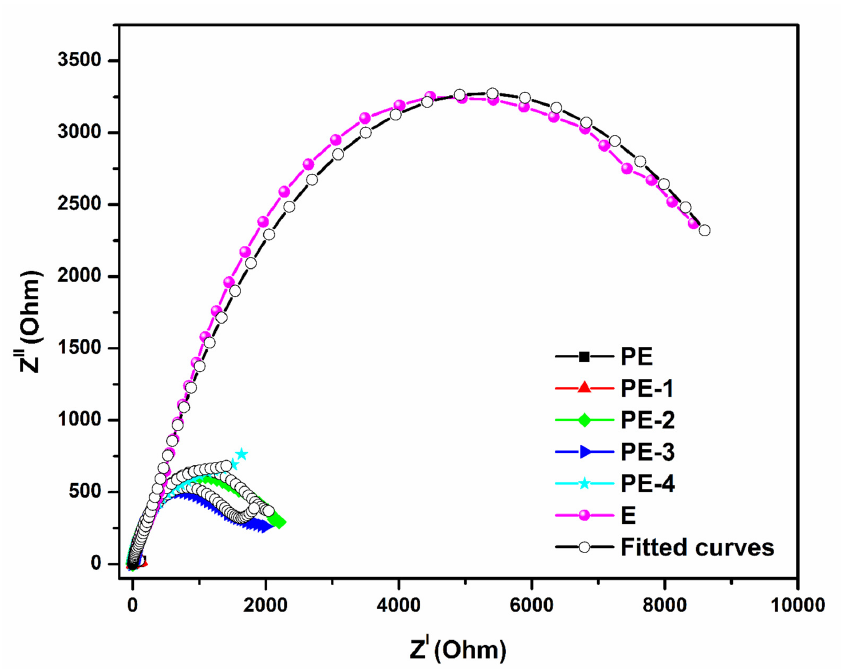
Figure 6. Electrochemical impedance spectra of plane PVA (PE), PVA − 20 wt% TEOS (PE − 1), PVA − 40 wt% TEOS (PE − 2), PVA − 60 wt% TEOS (PE − 3), PVA − 80 wt% TEOS (PE − 4) and 36 wt% H 2 SO 4 (E).